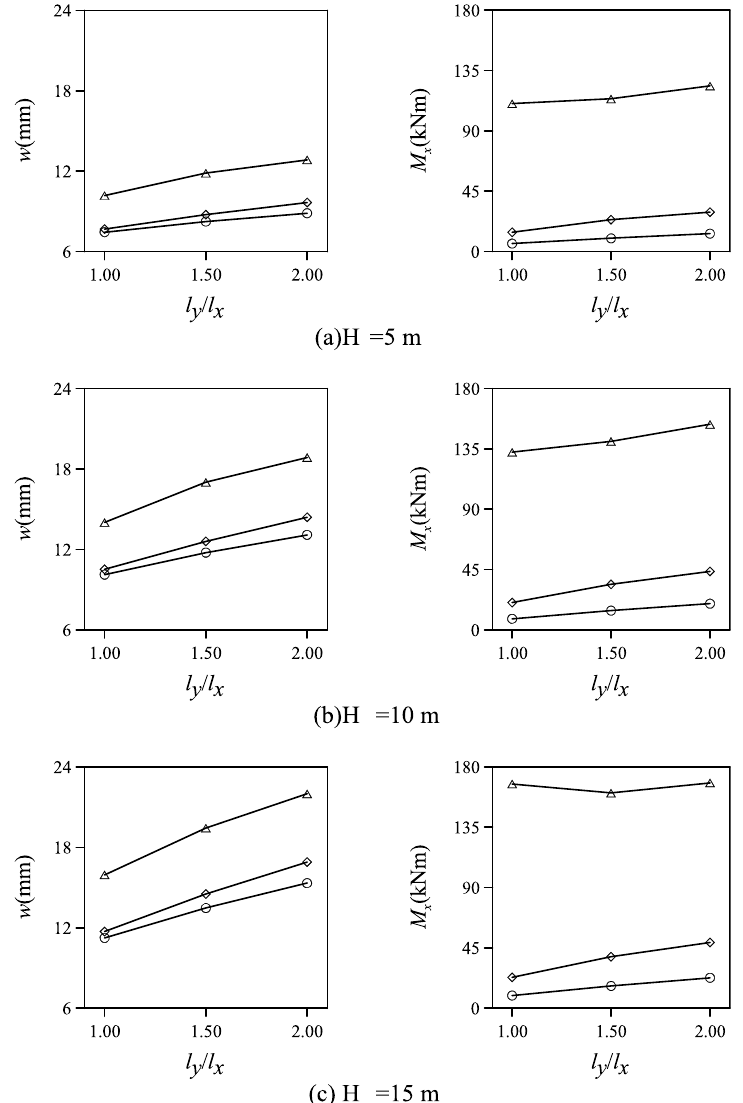
Fig. 7. The variation of the maximum displacement and bending moments with aspect ratio. − Δ − , without beam; −♦− , 1.00 × 1.00 beam; ◦ − − , 1.00 × 1.50 beam. and Cheung [15], based on Kirchoff plate theory in which transverse shear strains are omitted. The same example is solved by PBQ8 fi nite element using selective reduced integration techniques. As seen from Table 2 the results are in a good agreement with the reference